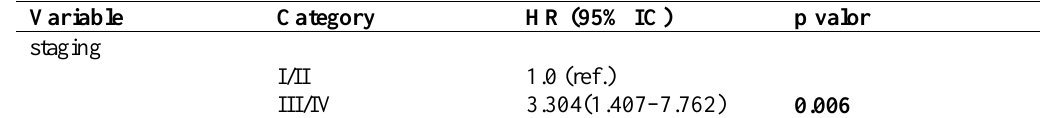
Table 5. Multivariate analysis by Cox regression model: Overall survival: Disease-free